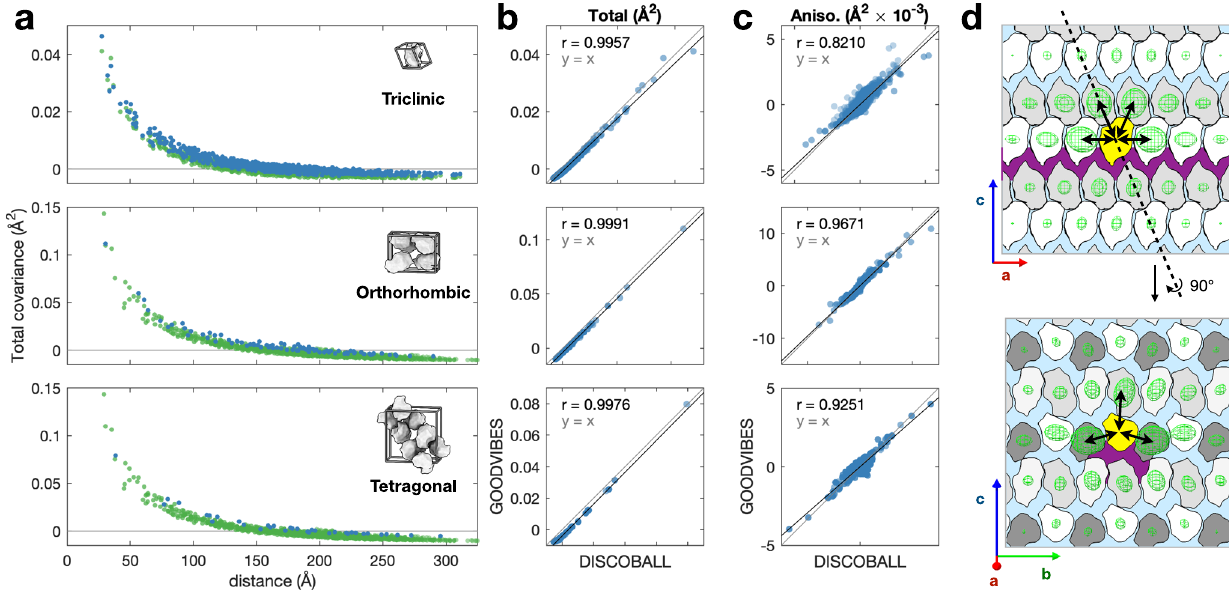
Fig. 4 | DISCOBALL analysis and validation of lysozyme polymorph datasets and insight into crystal mechanics. Displacement covariances matrices (joint- ADPs) were estimated for triclinic, orthorhombic, and tetragonal polymorphs (top to bottom in a – c ) and split into total and anisotropic components for further analysis(de fi nedinMethods). a ThetotalcovariancefromDISCOBALL(bluepoints) andGOODVIBES(greenpoints)decayswithdistancebetweenproteinmolecules,as expectedforanelasticcrystal. b TheGOODVIBES fi tshowsimprovedagreementto thetotalcovariancesforallpolymorphs(Pearsoncorrelations, r ,inset). c Validation